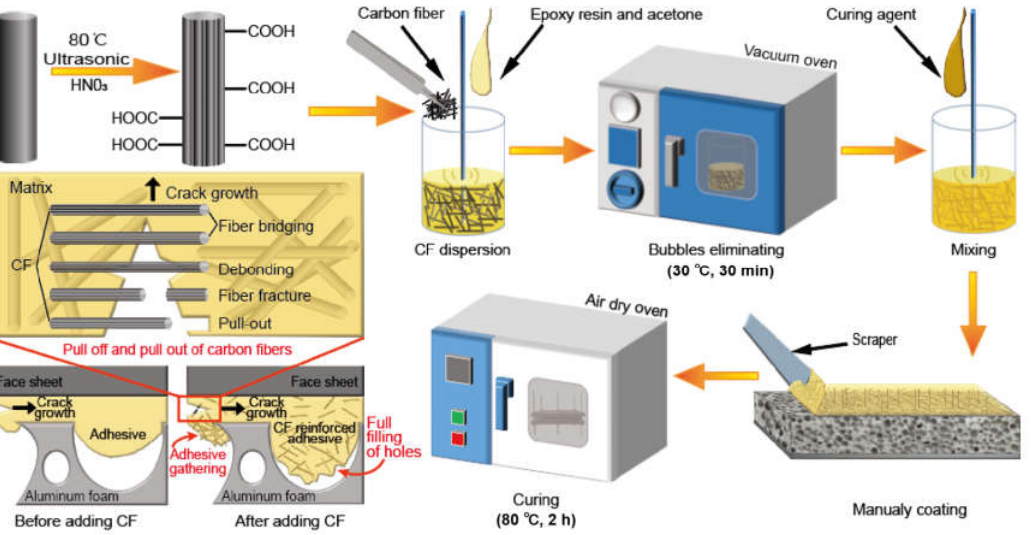
Figure 1. Schematic illustration of the fabrication process for short carbon fiber reinforced Alumi- num Foam Sandwich Structure (AFS) and reinforcement mechanism of the reinforced interface.